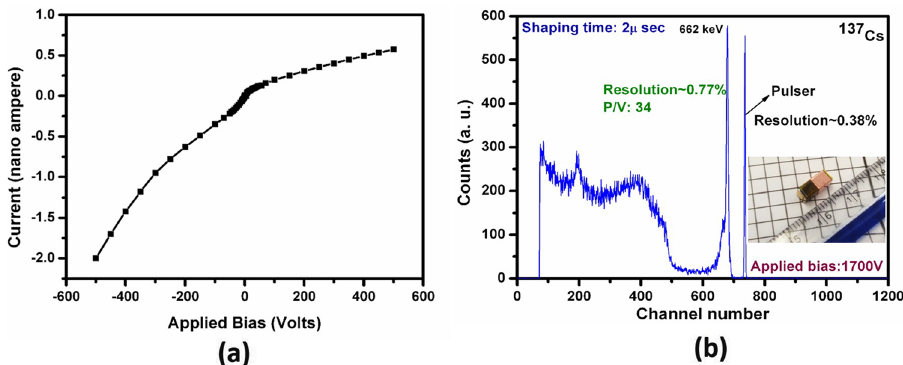
Figure 5. ( a ) Dark I–V characteristics of the FG detector at room temperature and ( b ) pulse height spectrum of 137 Cs source of the Frisch-grid detector (shown in the inset) fabricated from as-grown Cd 0.9 Zn 0.1 Te 0.98 Se 0.02 THM-grown ingot. Here, P/V is commonly known as Peak-to-Valley. It is the ratio of the peak count at 662 keV to the minimum count in the valley region (in the range of ~ 480–600 channel number. Detector dimensions: 3.5 × 3.5 × 9.15 mm 3